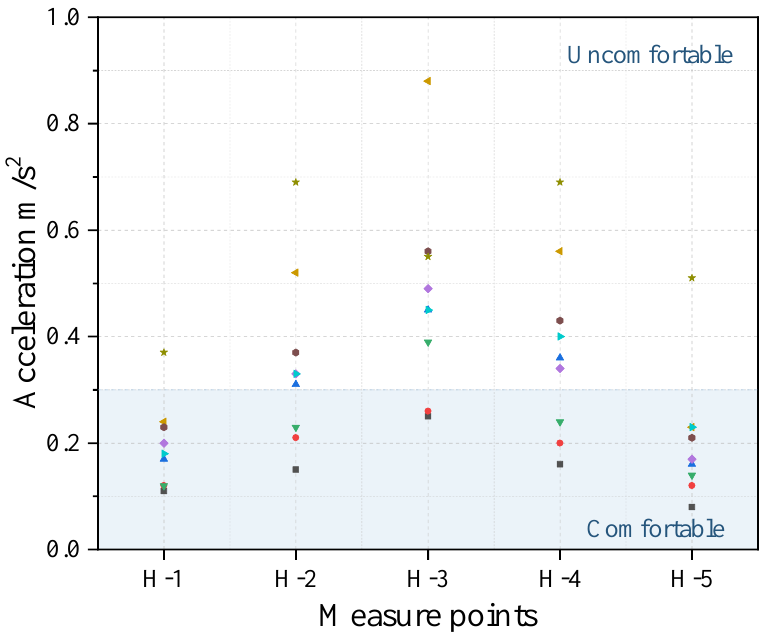
Figure 10. Comfort distribution of human-induced vibration.